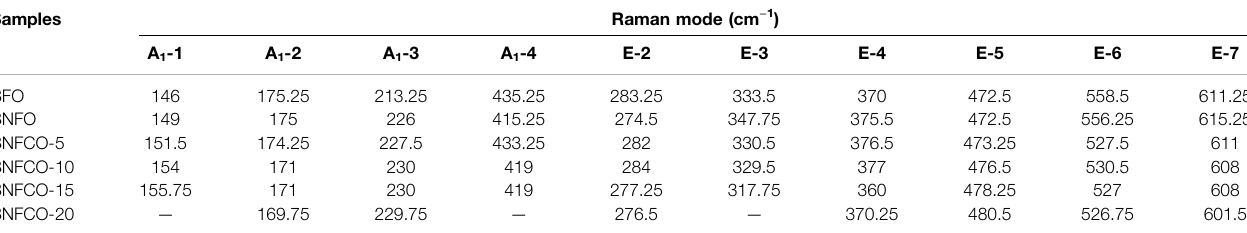
TABLE 1 | Comparison of Raman mode frequency in the literature with this experiment (BFO).